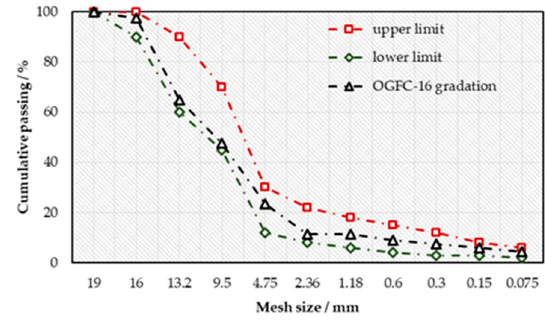
Figure 2. Gradation of open graded friction course (OGFC)-16 in the test.